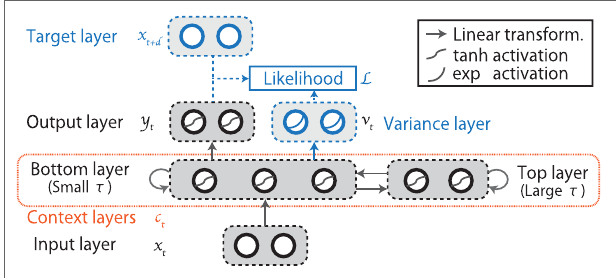
FIGURE 2 | The structure of the MTRNN with two stacked context layers . The data flow fed into/out of the I/O layer of the RNN consists of the words, robot vision, and joint angles. Blue-colored parts are used only for learning and explained in detail in Section